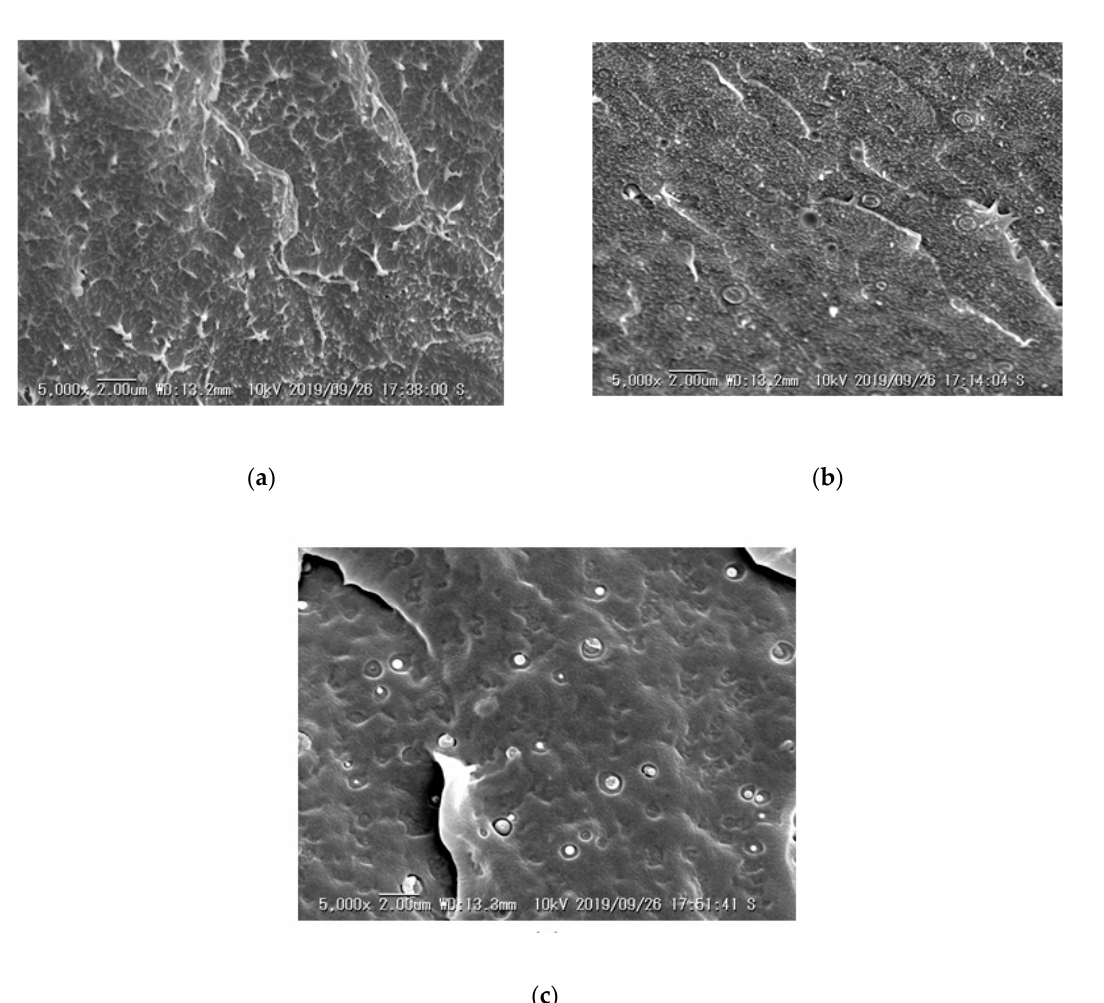
ascribed to the crosslinking between PS and polyethylene cribed to the crosslinking between PS and polyethylene [10].